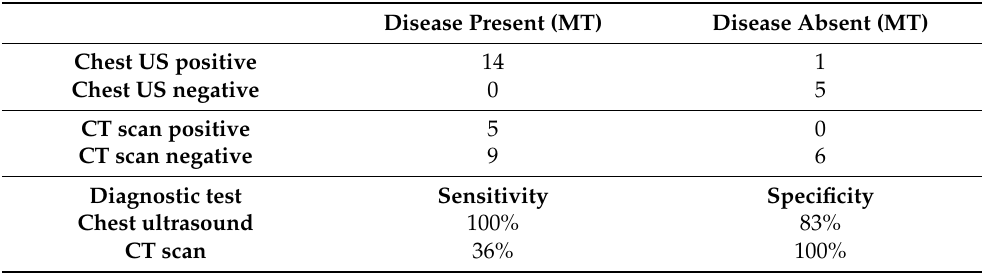
Table 8. Subgroup of 20 cases without contrast enhanced (c.e.) CT scan of the chest. Chest US and CT scan compared with MT gold standard for pleural abnormalities in